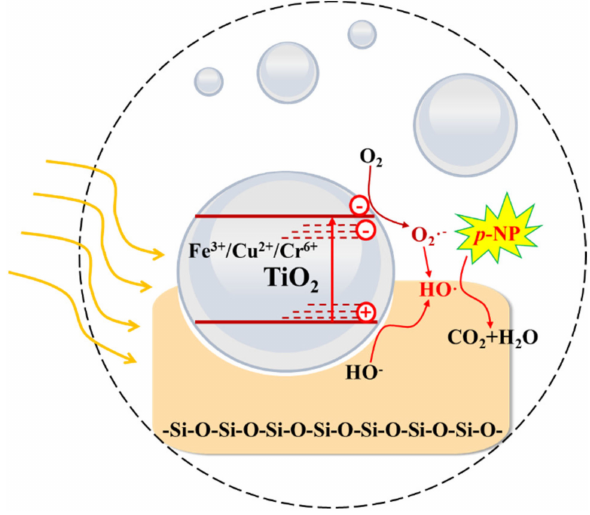
Figure 4. Mechanism of photocatalysis under visible light irradiation